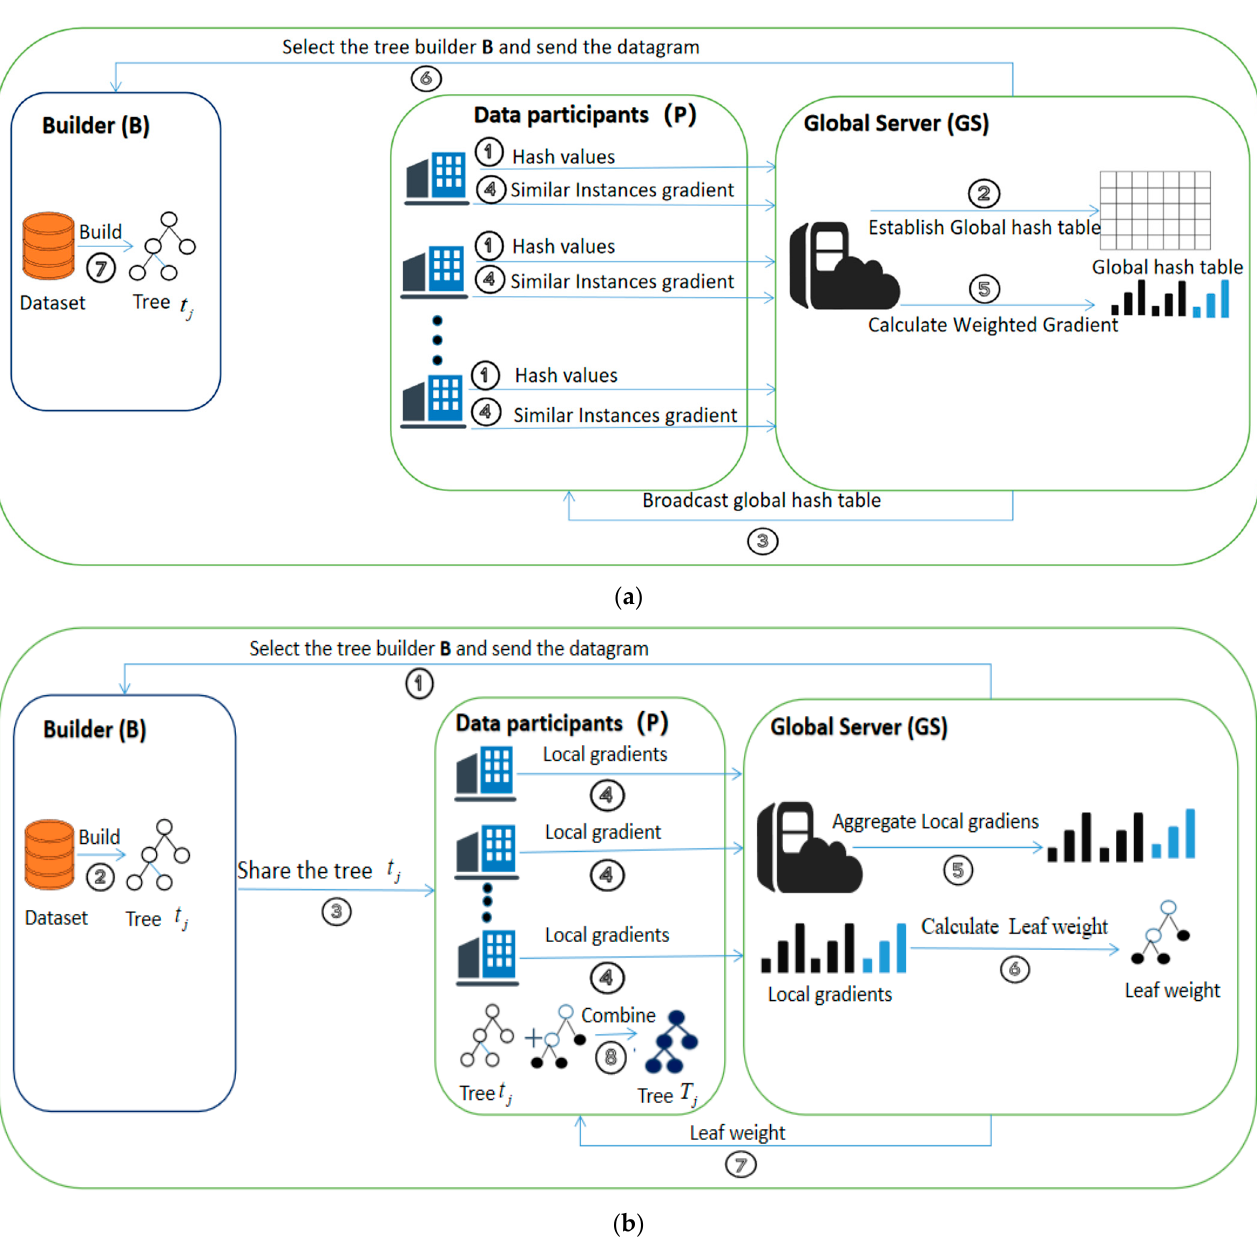
Figure 3. This is the framework of SeFB. ( a ) The stage of building a tree. ( b ) The stage of updating the tree.